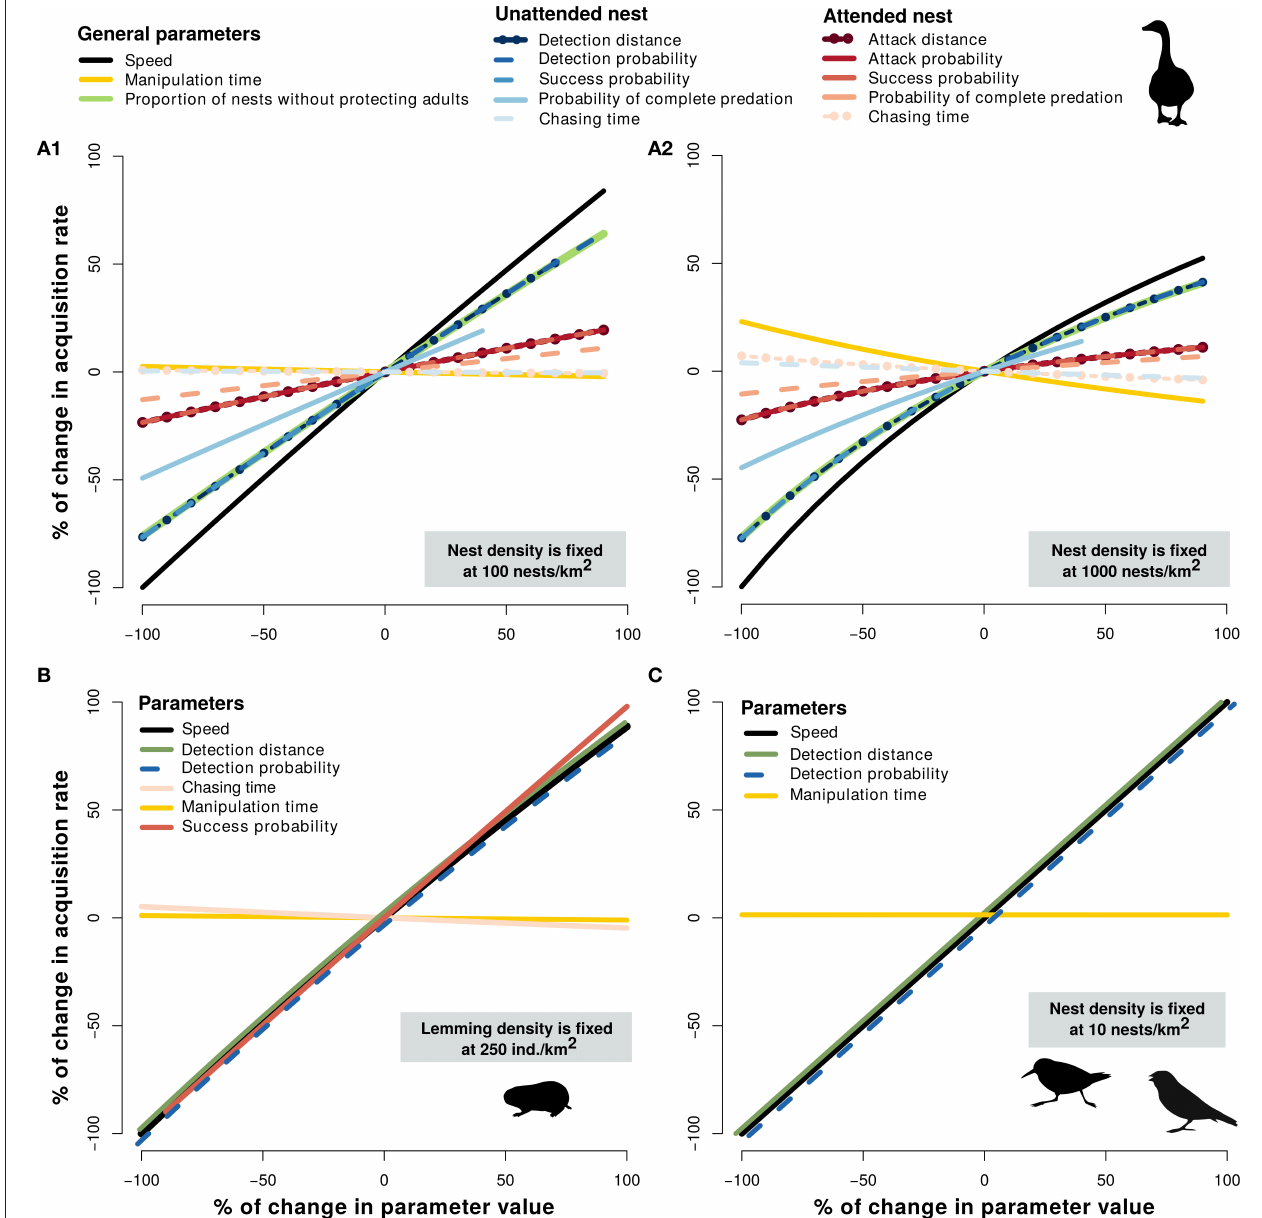
FIGURE 3 | Sensitivity of predator acquisition rates to changes in parameter values of the mechanistic models used to assess the functional response of arctic fox to goose nests [at 100 (A1) , and 1,000 nests/km 2 (A2) ], to lemmings at 250 ind./km 2 (B) and to passerine and sandpiper nests at 10 nests/km 2 (C) . Sensitivity analyses are presented at intermediate densities for lemmings and passerine and sandpiper nests, since the results were very similar within the range of densities observed in our study